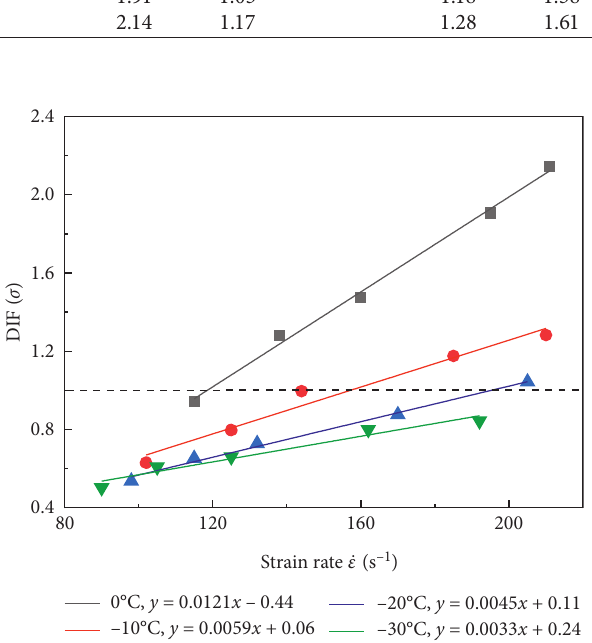
Figure 5: Relationship between DIF and strain rate.